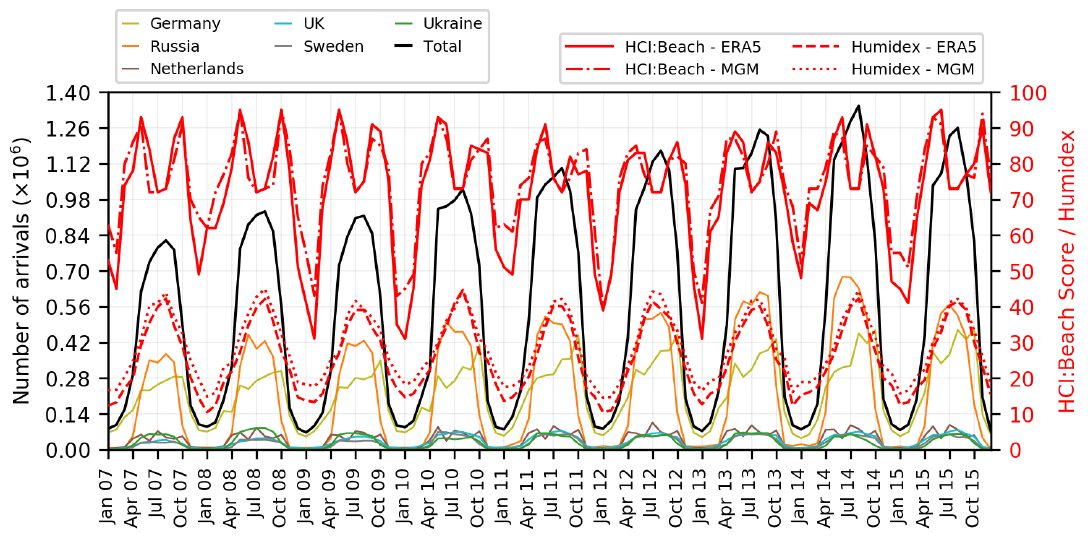
Figure 8. Comparison of HCI:Beach and Humidex scores (from ERA5 reanalysis & MGM observation data) with arrivals from top source markets to Antalya,